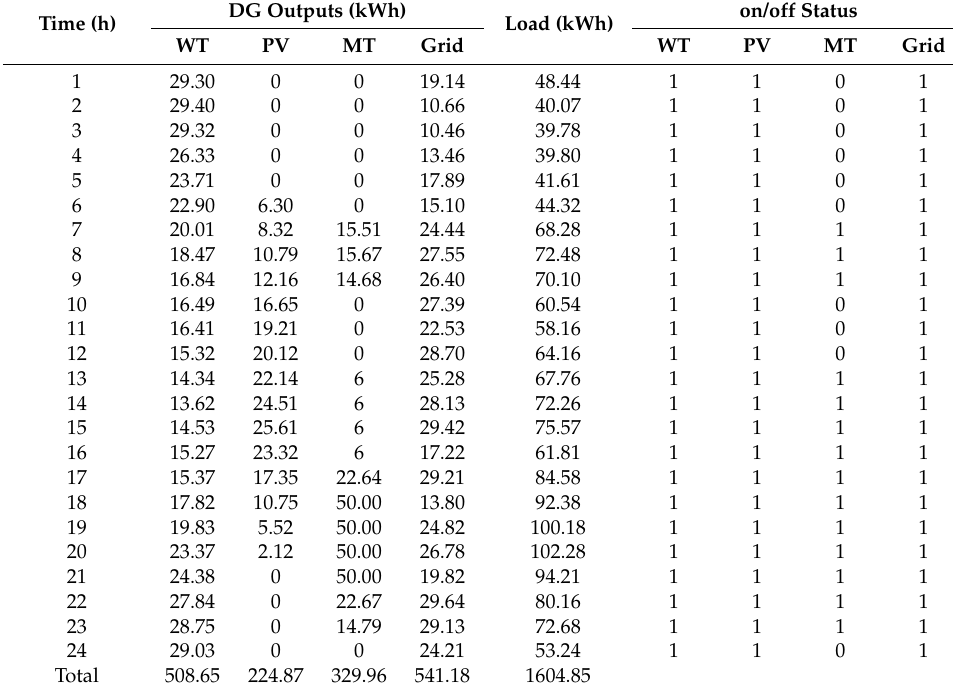
Table 3. Results of Scenario 1 (total cost = 586.64